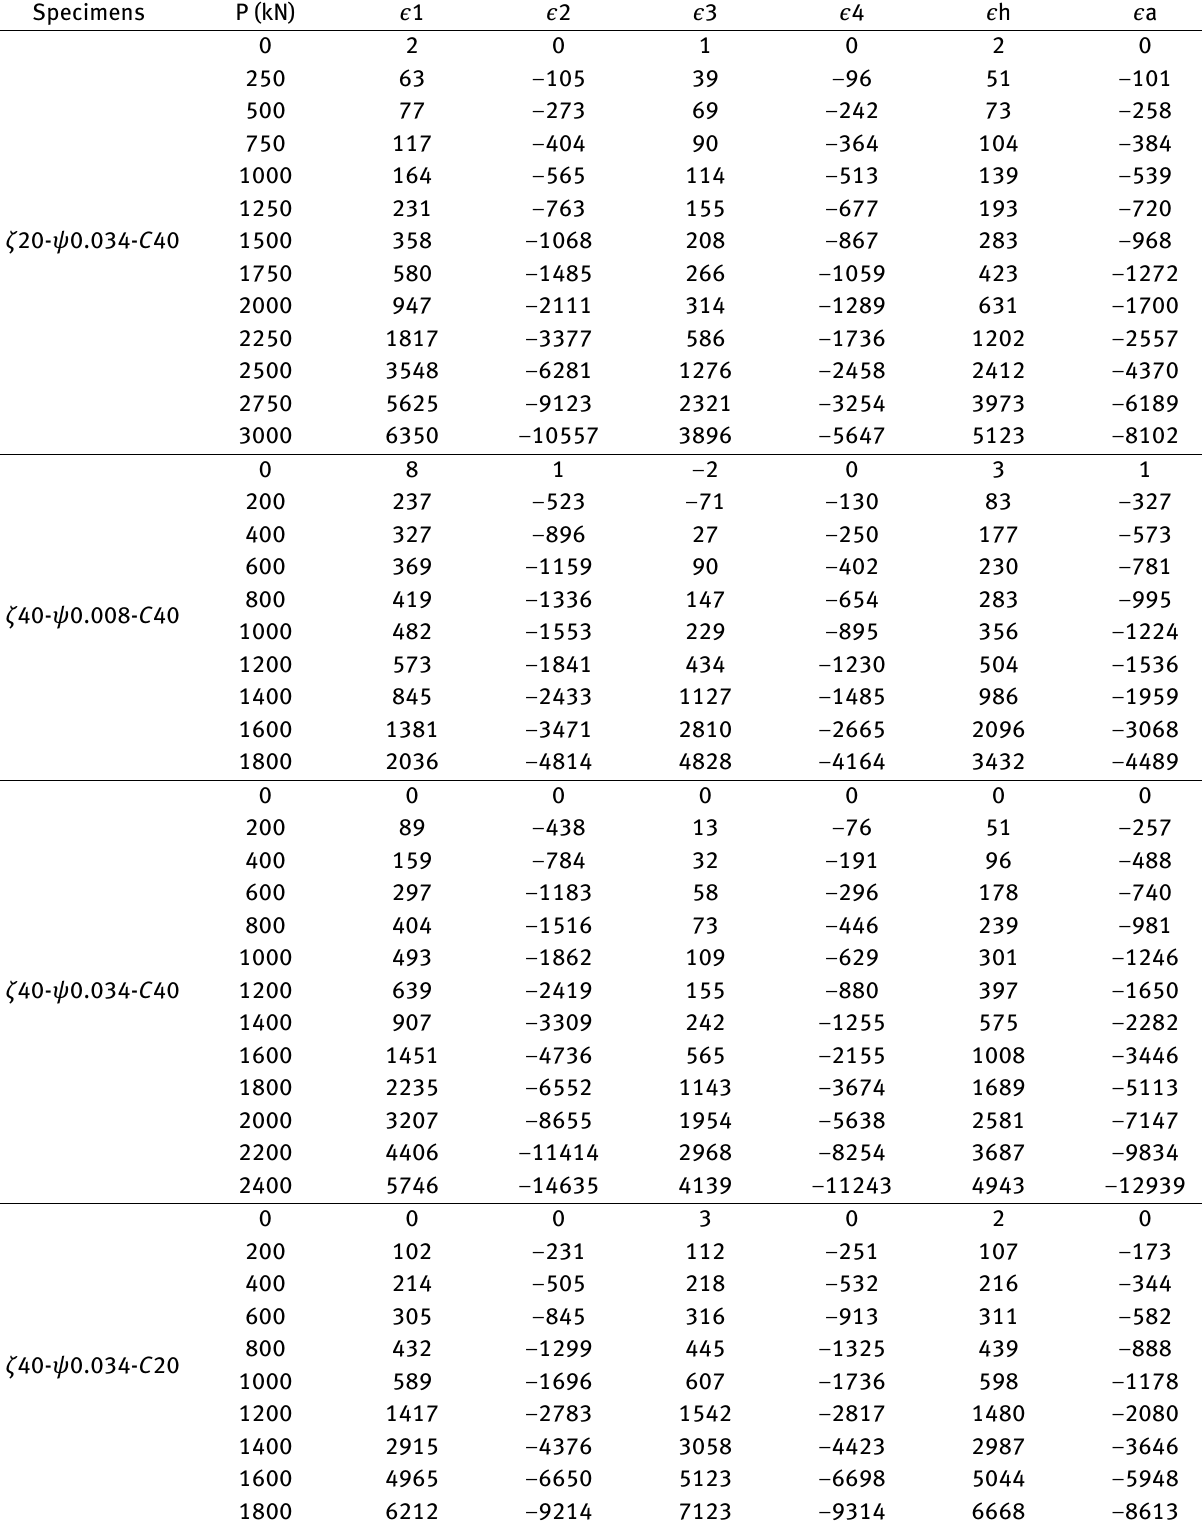
Table 5: Strains of the specimens Specimens